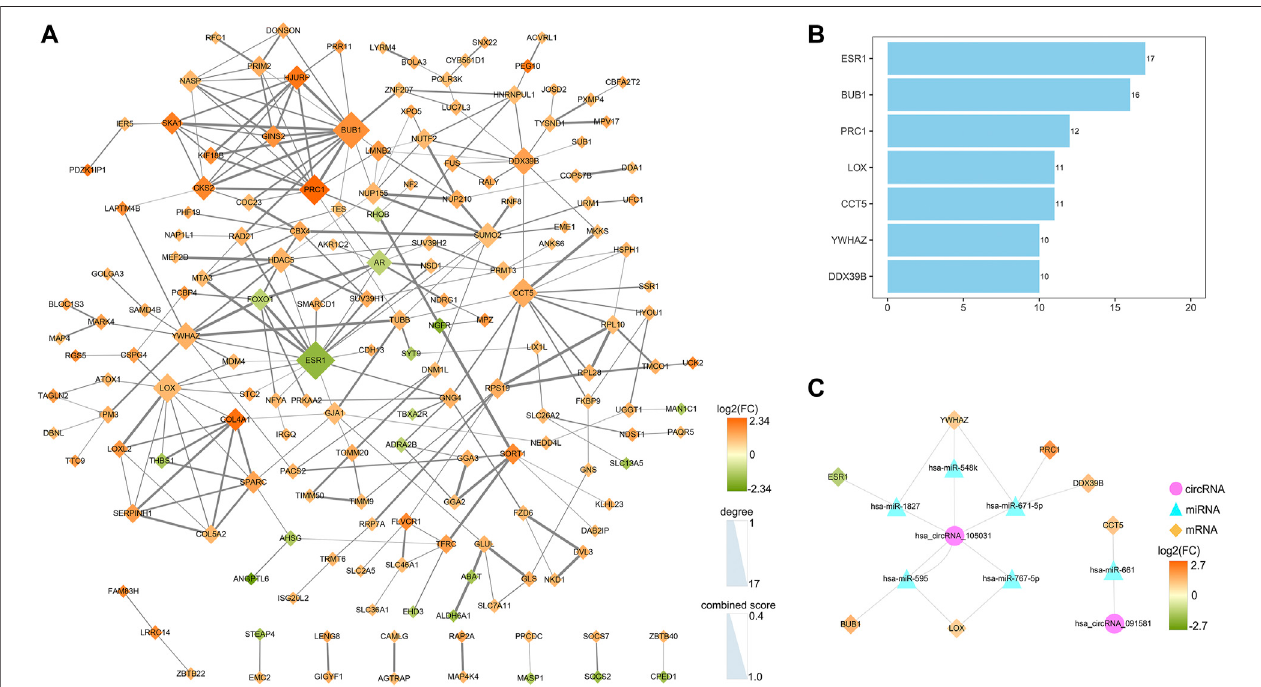
FIGURE9| Identi fi cationofhubgenesfromthePPInetworkandreconstructionofthecircRNA-miRNA-mRNAnetwork. (A) APPInetworkof222targetgeneswas analyzed by the STRING (https://www.string-db.org/) online tool and visualized by the Cytoscape software (3.8.3). After removing disconnected nodes, 169 nodes and 269 edges were remained in the PPI network. The node size represents the connection degree with other genes. The size of the edges demonstrates the combined score of two interacting genes. (B) Bar plot of the connectivity of the seven hub genes. (C) CircRNA-miRNA-hubgene regulatory network in HCC. The network, consisting of two circRNAs, six miRNAs, and seven hub genes, was visualized by the Cytoscape software (3.8.3). PPI, protein-protein interaction.